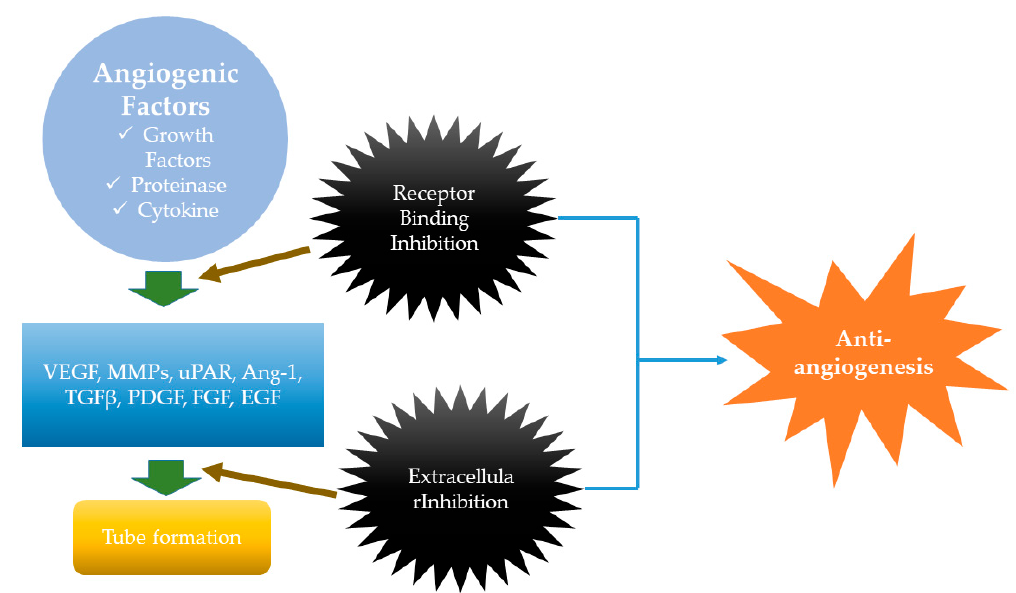
Figure 4. Angiogenesis mechanisms. Angiogenic growth factors induce the angiogenesis in tumor cells. This mechanism is usually mediated by factors such as VEGF (vascular endothelial growth factor), MMPs (matrix metalloproteinase), uPAR (urokinase receptor), Ang-1 (angiopoietin-1), TGF β (transforming growth factor β ), PDGF (platelet-derived growth factor), FGF (fibroblast growth factor), and EGF (epidermal growth factor). This leads to tube formation. However, during these processes, various inhibitions occur, such as receptor binding inhibition and extracellular inhibition. These lead to inhibition of angiogenesis, or, as mentioned in this review,